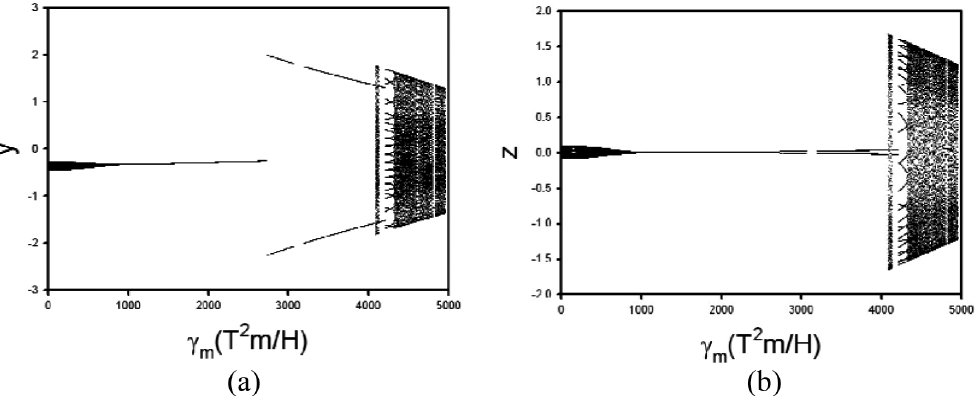
Fig. 14. Bifurcation diagram of displacement versus electromagnetic parameter γ m . (a) y -displacement; (b) z -displacement. D = 0.25 m, ω = 600 rad/s, ρ s = 7800 kg/m 3 , E = 206 GPa, C = 0.001 D , C e = D /1600, L = 3 m, L b = D /4, e ¯ m = 0 . 0001 m, x a = 0.08, x b = 0.92, μ o = 0.001 Pa ·